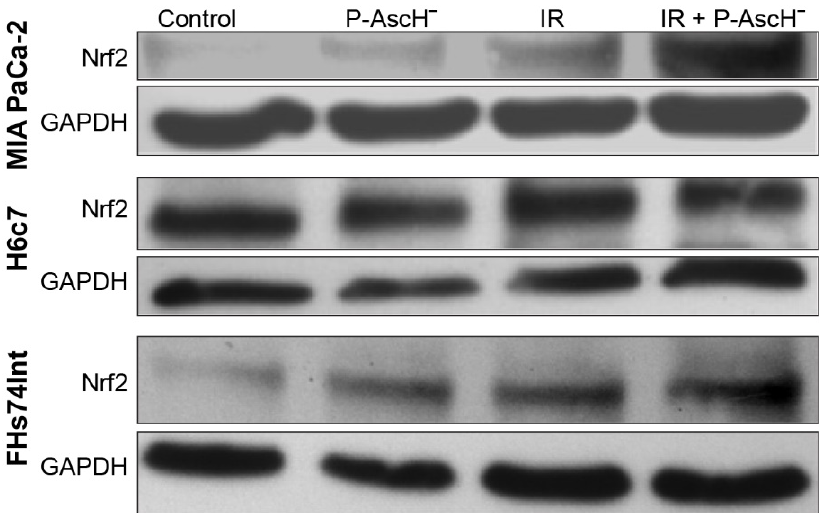
Figure 1. Changes in nuclear factor-erythroid 2-related factor 2 (Nrf2) activation of normal cells vs. pancreatic cancer cells (PDACs) after pharmacological ascorbate (P-AscH − ), radiation, or the combination of both. Western blot analyses show that P-AscH − , radiation, or radiation + P-AscH − induce Nrf2 in MIA PaCa-2 and FHs74Int cells, but no change occurs in H6c7 cells. Cells were treated with P-AscH − (5 pmol/cell, 1 mM) for 1 h, 5 Gy, or 5 Gy + P-AscH − in DMEM − 10% fetal bovine serum (FBS). After treatment, cells were cultured in their growth media for 24 h before protein was harvested for Western blot